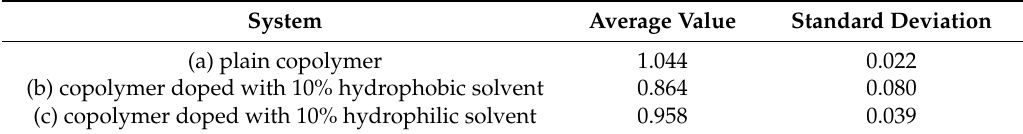
Table 2. Statistics of five peak values in the density distribution of B beads originating from Figure